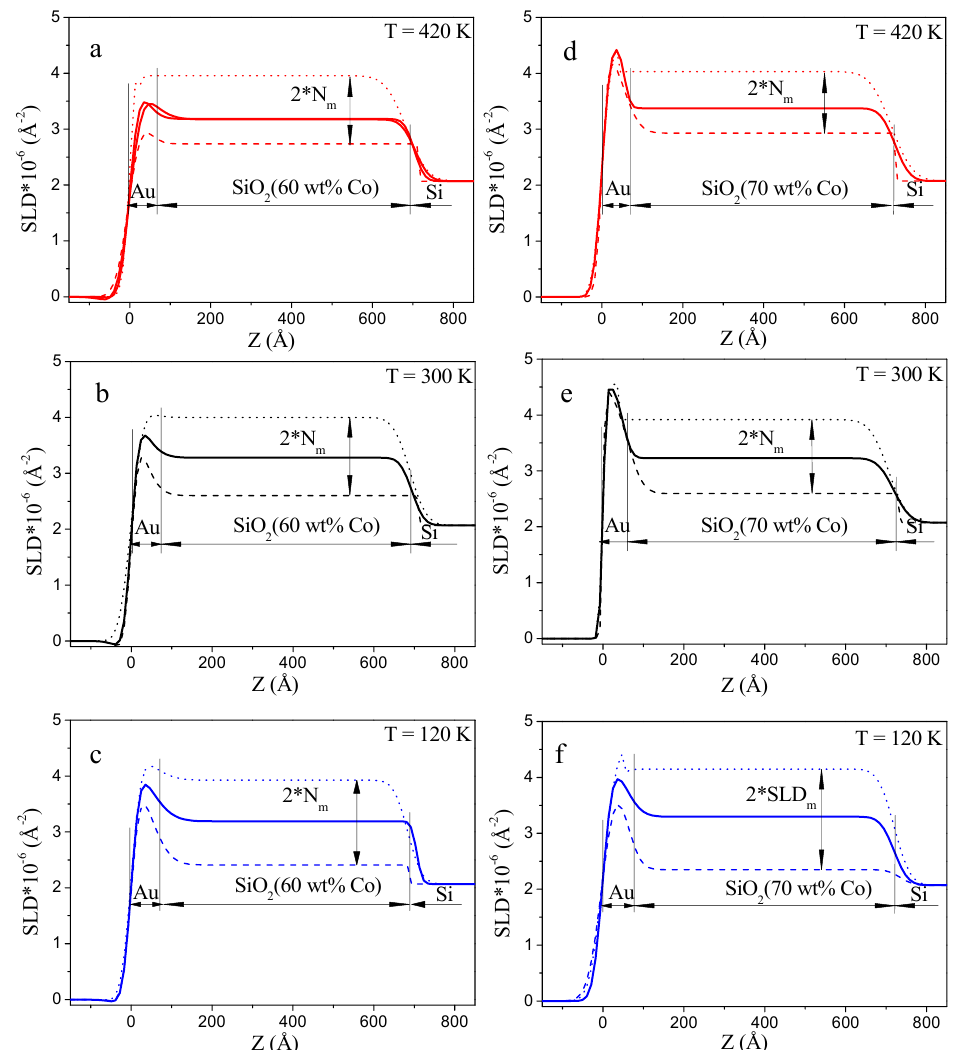
Figure 7. The SLD profiles ρ + (dot line) and ρ − (dashed line) of the samples Au/SiO 2 (60 at.% Co)/Si ( a – c ) and Au/SiO 2 (70 at.% Co)/Si ( d – f ) at B = 240 mT for T = 420 K ( a , c ), 300 K ( b , e ), and 120 K ( c , f ). The solid line corresponds to the SLD profile at H = 0 T for every polarization of neutrons. Table 2. Parameters of the model used to approximate the PNR curves for Au/SiO 2 (60 at.% Co)/Si.